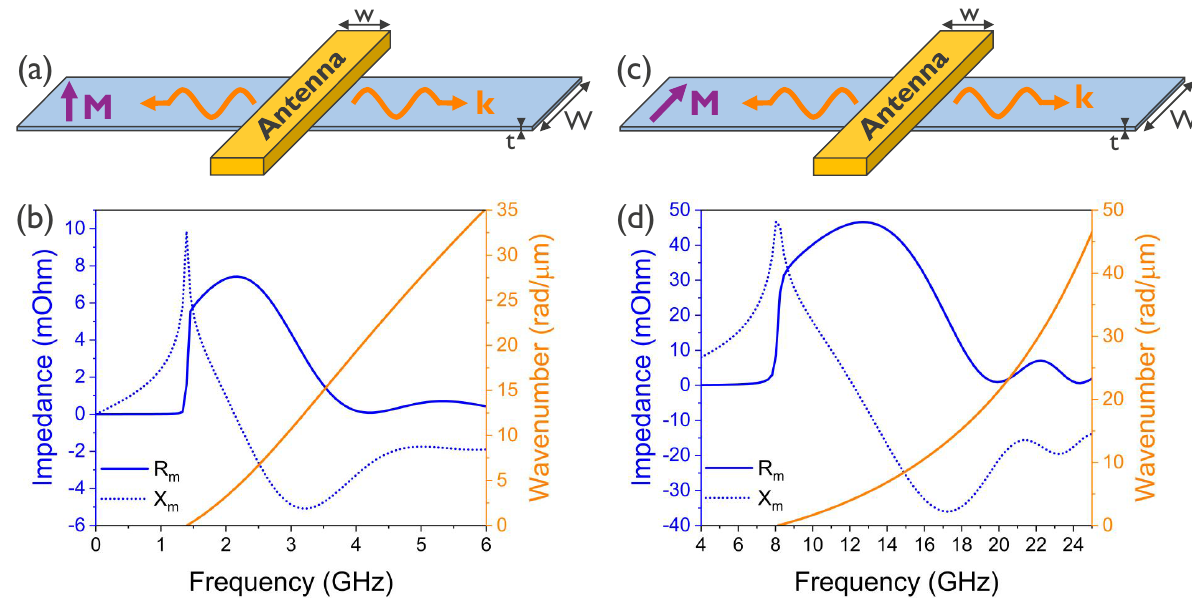
Figure 3. Spin-wave impedance of a 300 nm wide antenna on top of a 1 µ m wide and 20 nm thick